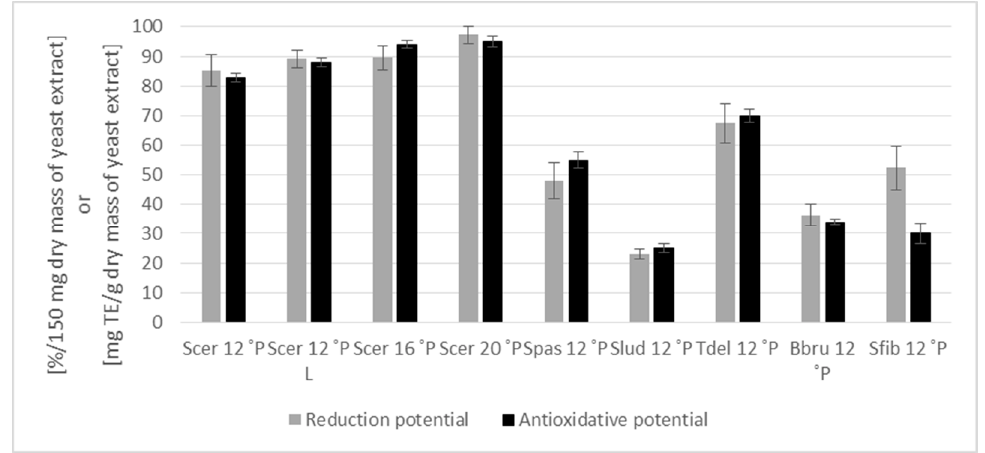
Figure 8. Reduction potential of yeast extract made from spent yeast ( S. cerevisiae TUM 68) of beer production via mechanical disruption method (sonotrode); influence of original gravity (12 ˚ P, 16 ˚ P, 20 ˚ P), time of yeast cropping (after primary fermentation vs. after cold beer lagering (L)) and yeast strain (Scer, Spas, Slud, Tdel, Bbru, Sfib); for results of ANOVA and pairwise t-test, see text .